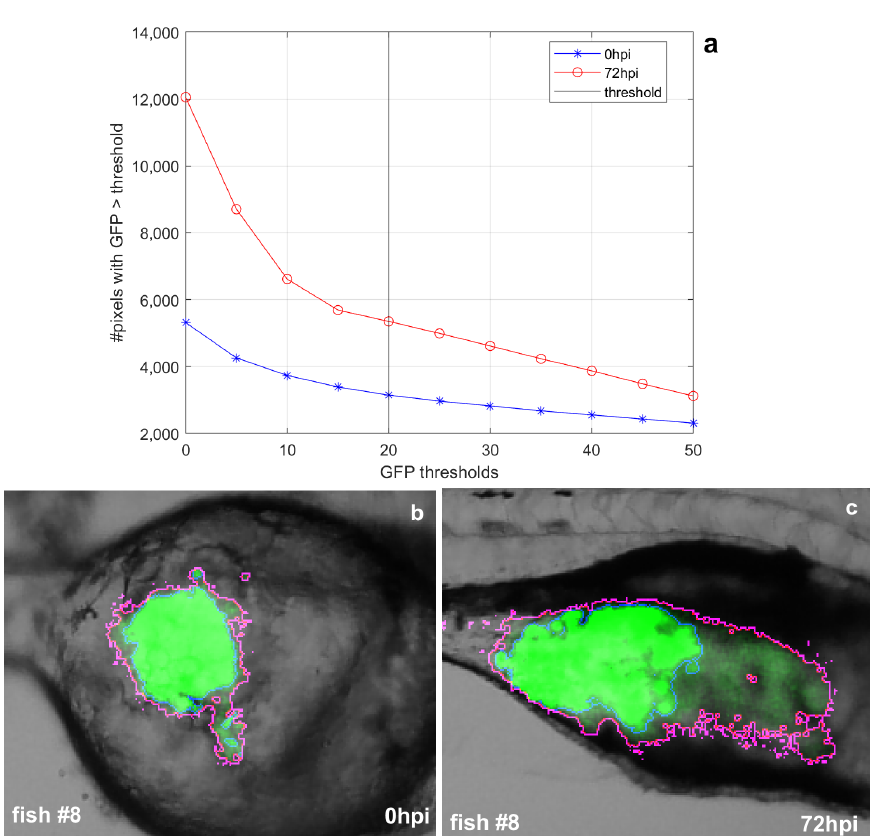
Figure 2. Example of autofluorescence in the yolk sac for fish #8 at 0 hpi and 72 hpi. ( a ) The graph shows the area evolution with respect to the GFP threshold in steps of 5. The abrupt decay in the area caused by the fish autofluorescence can be observed. When the area remains stable for 3 iterations, the threshold is fixed. ( b ) threshold at 0 hpi in magenta and final threshold (20 in this case) in blue. The GFP (green channel) was artificially enhanced in order to make visible the autofluorescence causing the initial contour. This is better seen in the image at 72 hpi ( c ). The original images are shown in Figure 3, where the autofluorescence cannot be